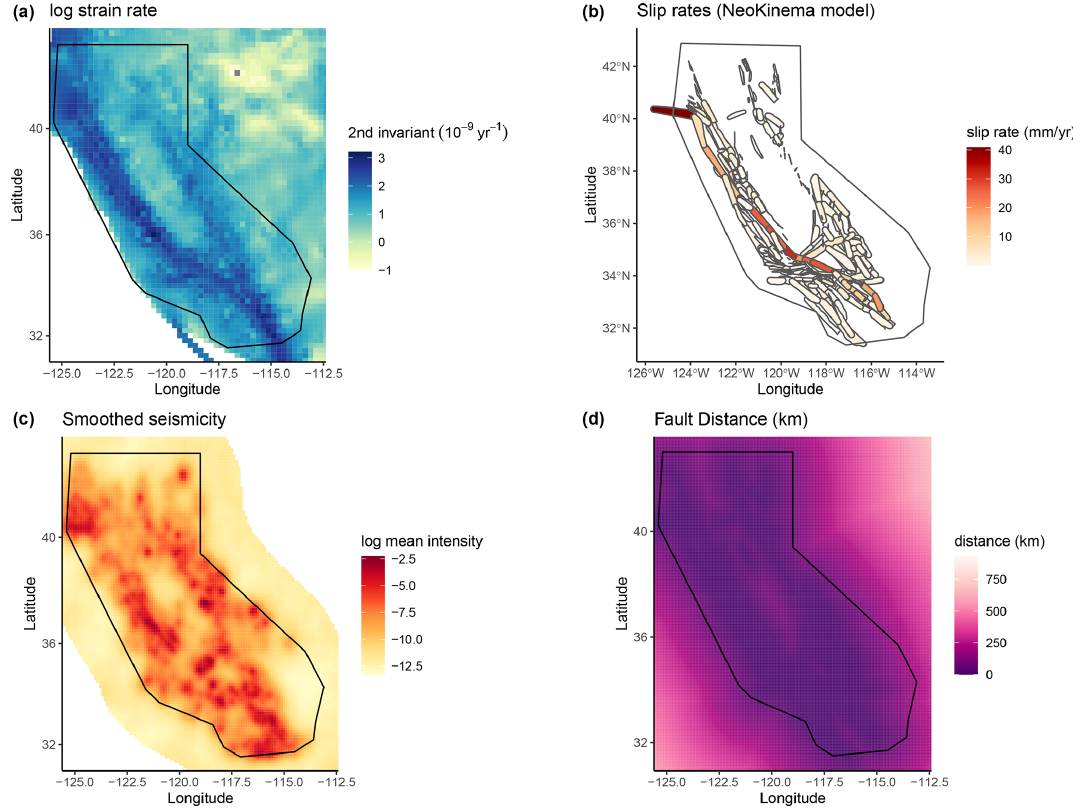
Figure 2. Input model covariates: (a–d) strain rate (SR), NeoKinema slip rates from UCERF3 (NK), smoothed seismicity from a Gaussian random field for events before 1984 (MS), distance to nearest (UCERF3, dip and uniformly buffered) fault in km